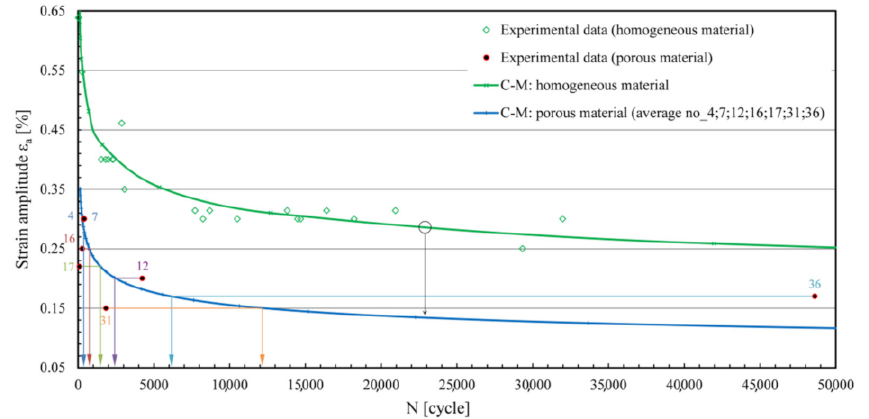
Figure 3. Preliminary assessment of the error in predicting the fatigue life if the strategy is based on a uniform shift of the C–M